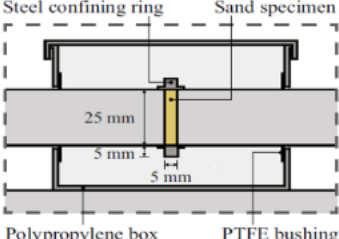
Figure 10. Section detail of specimen confinement (reprinted from Ref. [75]).